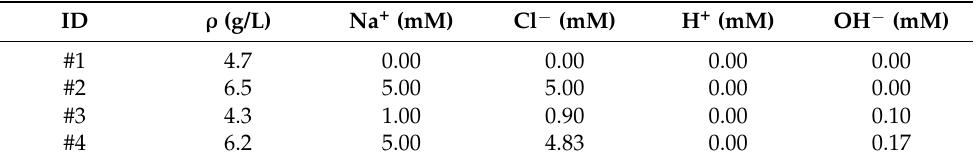
Table 3. Solution compositions based on additions from stock solutions (NaCl, NaOH) for the samples used for the cryo-XPS measurements reported in Table 2.